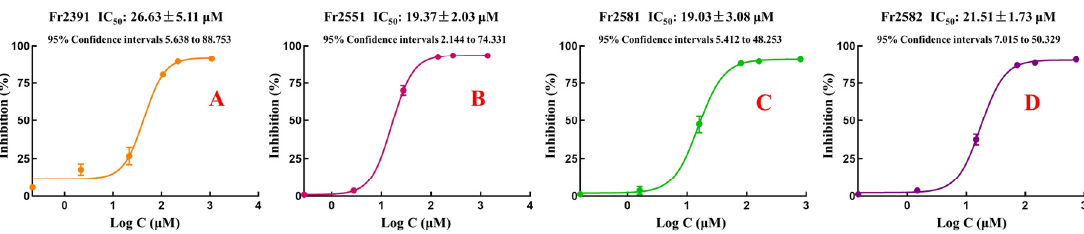
Figure 7. Antioxidant activities of Fr2391 ( A ), Fr2551 ( B ), Fr2581 ( C ), and Fr2582 ( D ) at different concentrations ( µ M). The IC 50 values were obtained after fitting the data with a logistic